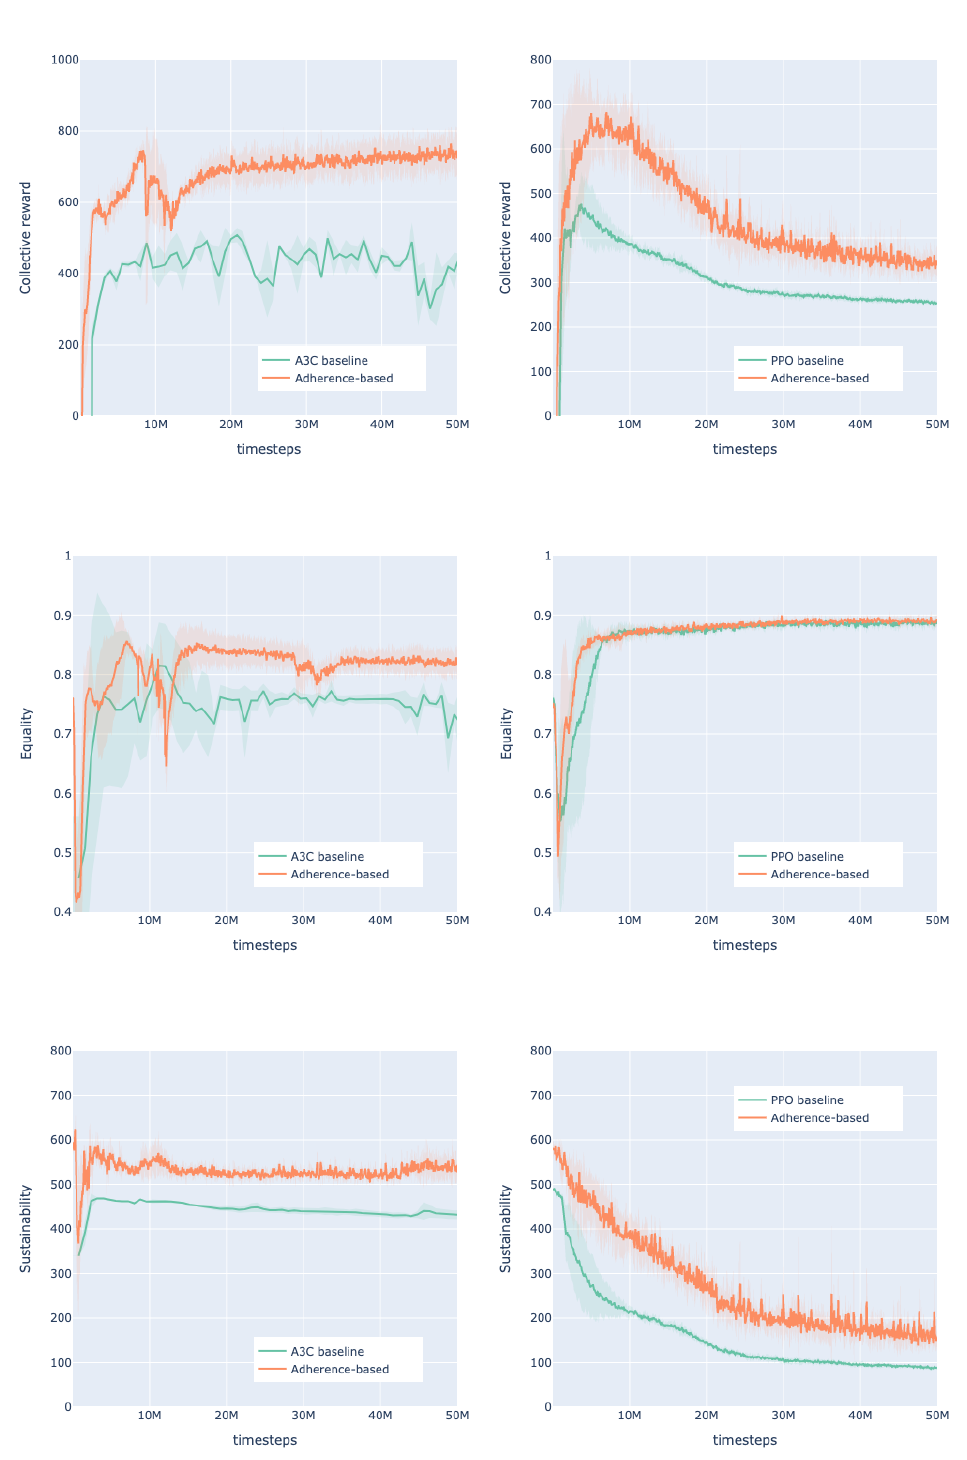
Figure 4. The effect of the adherence-based algorithm on social outcomes in Harvest. The social outcome metrics are collective reward, equality and sustainability, respectively. The left three figures are the results of our method applied to A3C. The right three figures are the experiment results based on